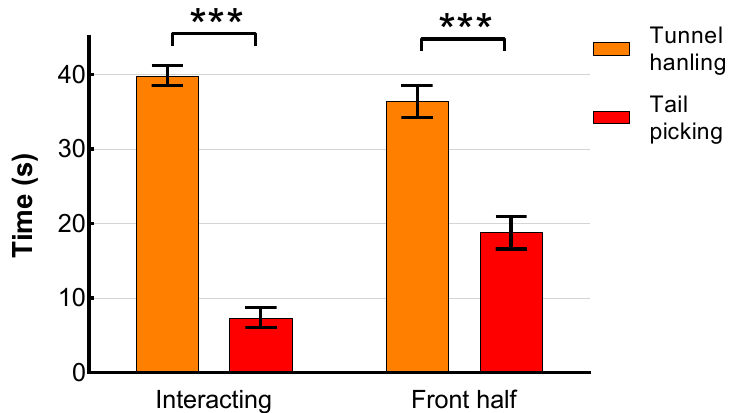
Figure 5. Time spent in front half of the cage and time interacting with the handler during 1 min Voluntary Interaction Test (VIT), separated for handling technique (orange—tunnel-handled, red— tail-picked). Errors bars represent 95% CI, *** p < 0.001.